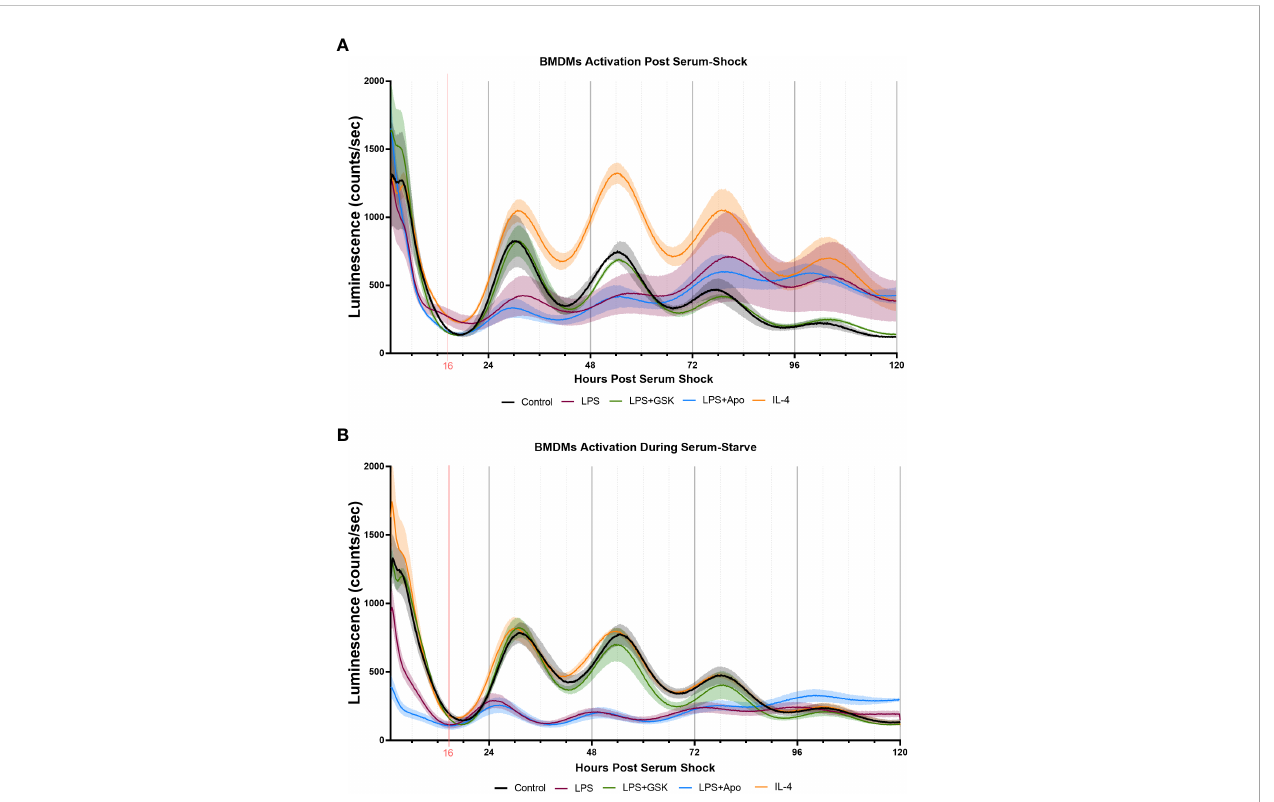
FIGURE 6 Inhibition of NOX2 by GSK2795039 under LPS activation conserves PER2 oscillation in mouse bone marrow-derived macrophages (BMDMs). Luminescence traces obtained luciferase measurement of serum-shock synchronized mouse BMDMs with and without LPS, and NOX2 inhibitors. (A) Cells were exposed to LPS with and without NOX2 inhibitors apocynin and GSK2795039 during the starve stage of the synchronization protocol. (B) Cells were exposed to LPS with and without NOX2 inhibitors apocynin and GSK2795039 post serum-shock stage of the synchronization protocol. Luciferase measurements were obtained by the LumiCycle HPS0 to HPS120 (n = 3). Data are represented as mean ±